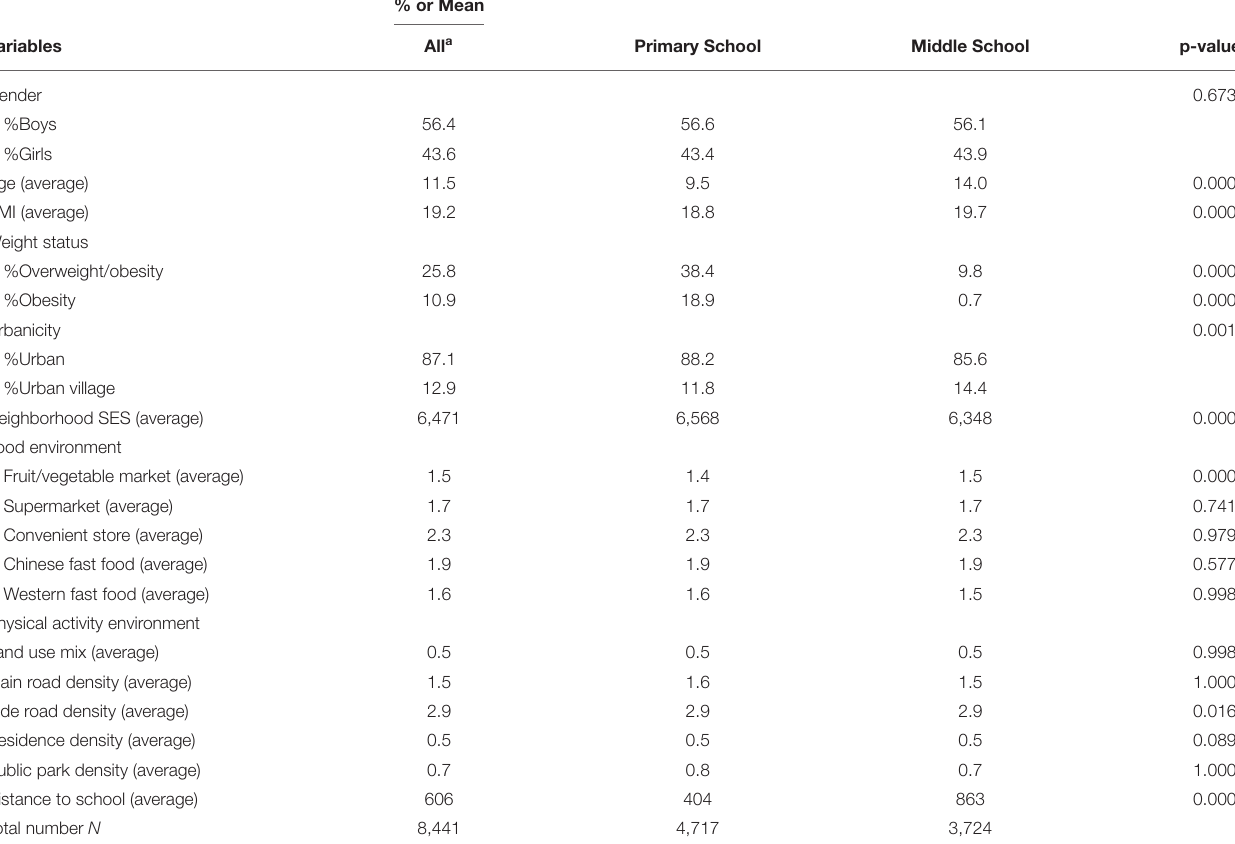
TABLE 1 | Sociodemographic characteristics, weight status, and built environment of the children. % or